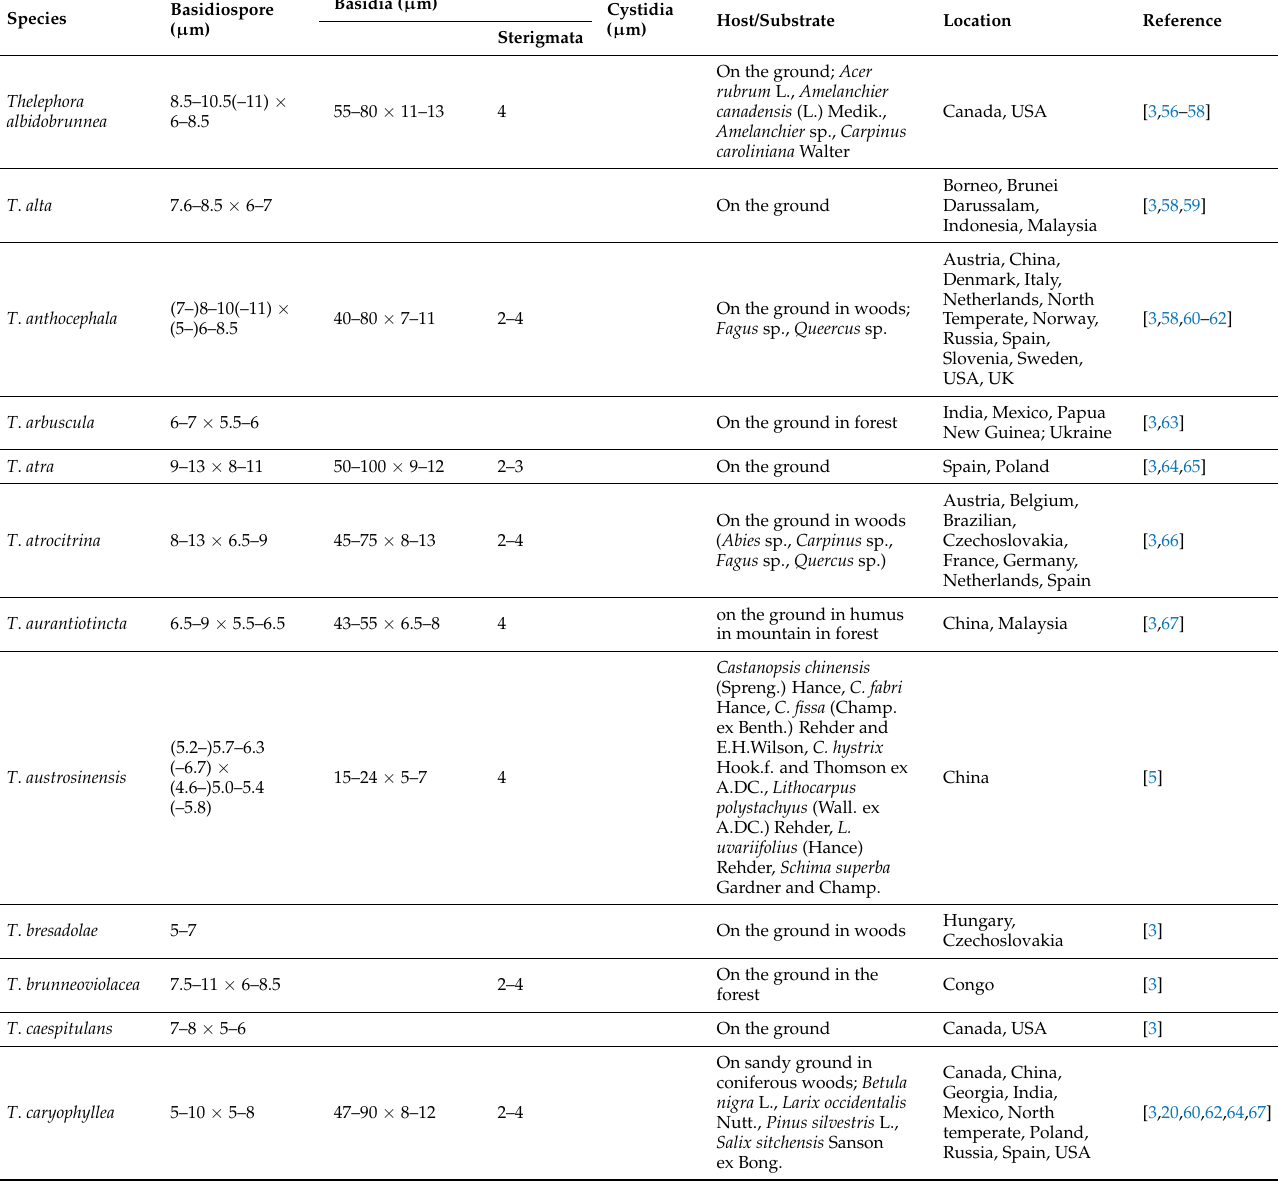
Table 4. Comparison of Basidiospore, Basidia, Cystidia, Host, Substrate, Location and corresponding references of Thelelphora species. The characteristics of newly generated taxa are shown in black